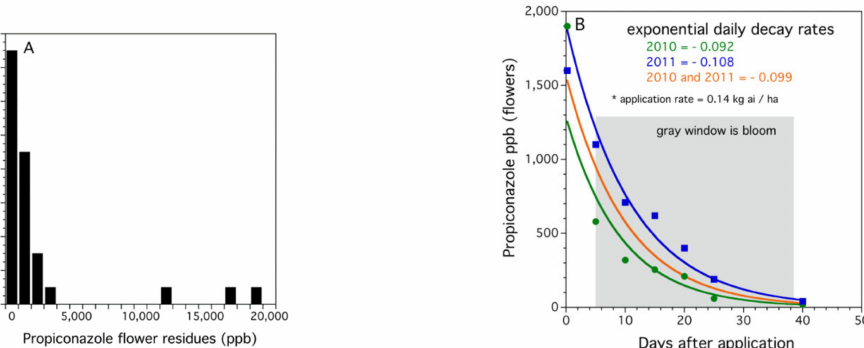
Figure 4. Frequency distribution of propiconazole residues on lowbush blueberry flowers during bloom ( n = 31 fields) ( A ); and decay rate of propiconazole on flower buds and flowers during bloom ( B ).